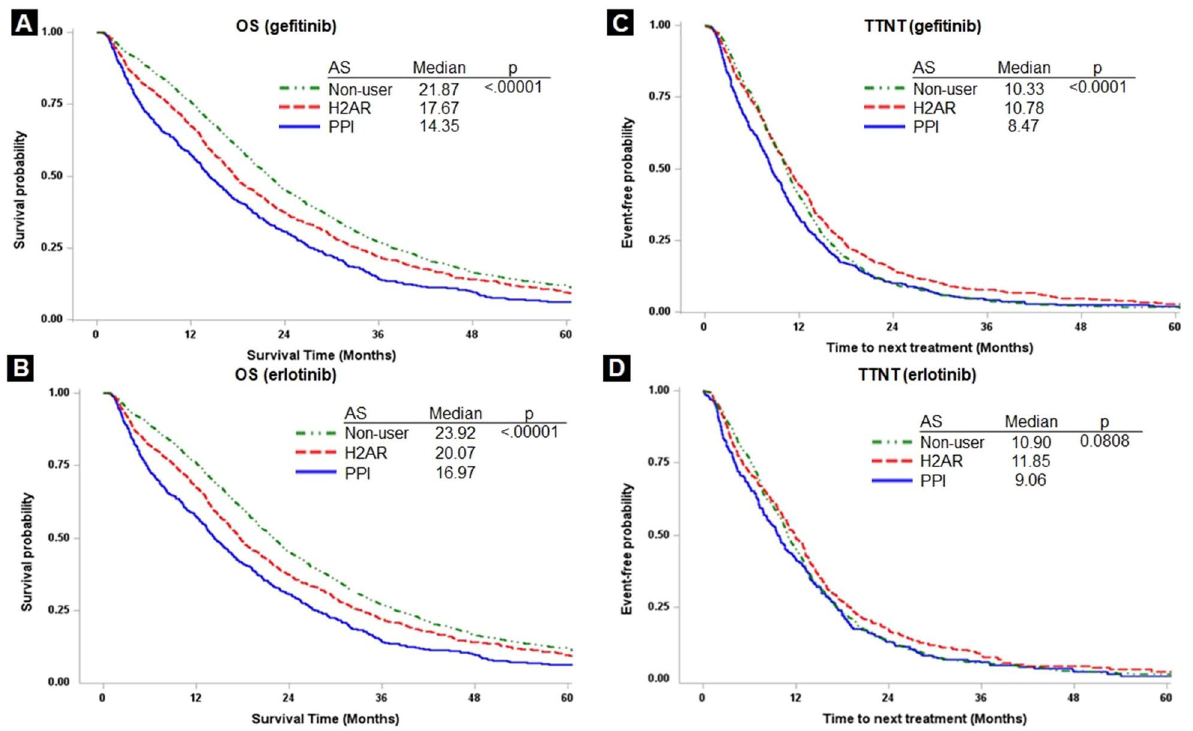
Figure 2. Kaplan–Meier survival curves of overall survival (OS) between PPI and H2RA groups in gefitinib ( A ) and erlotinib ( B ); and time to next treatment (TTNT) between PPI and H2RA groups in gefitinib ( C ) and erlotinib ( D